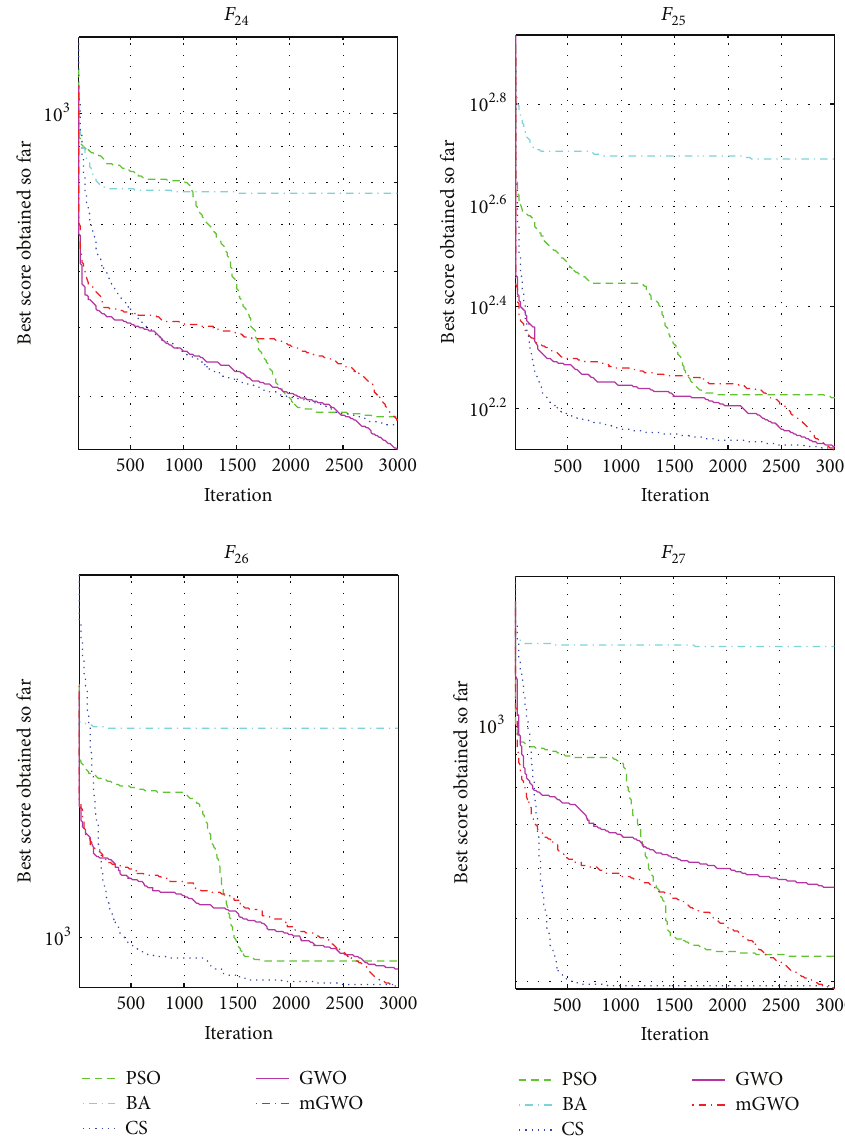
Figure 5: Convergence graph of composite functions.